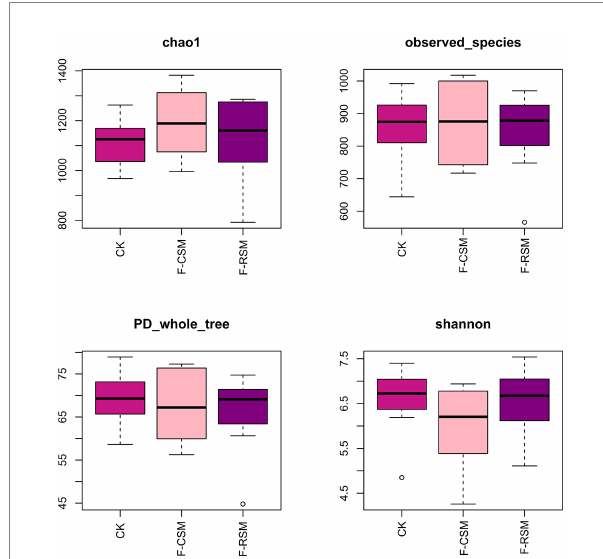
FIGURE 2 Effects of the diets on rumen alpha diversity of Hu sheep. CK, non- fermented group; F-CSM, fermented cotton seed meal TMR; F-RSM, fermented rapeseed meal TMR.